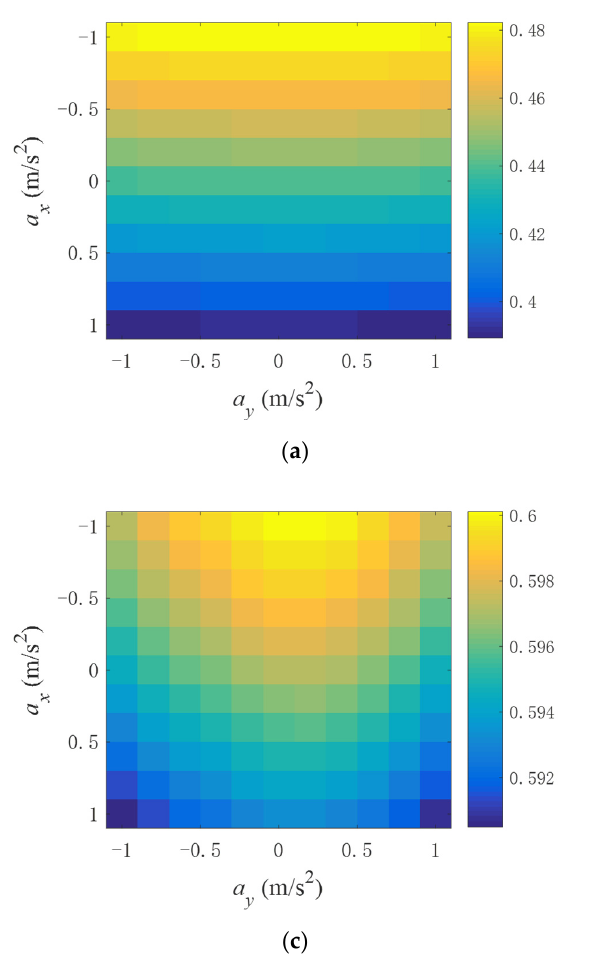
Figure 3. Phase errors under different accelerations. ( a ) Proposed range equation, ( b ) second-order Taylor approximated range equation, and ( c ) third-order Taylor approximated range equation. The parameters of the target are: R c = 20 km, v x = 5 m/s, and v y = 13 m/s. Table 1. Parameters of airborne CSSAR for simulation.